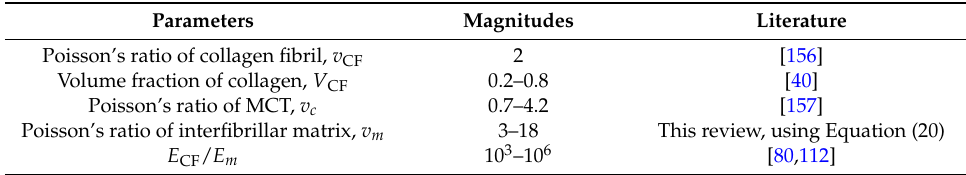
Table 3. Estimates of fibrillar and matrix-related Poisson’s ratio and modulus of elasticity parameters for understanding the behaviour of the interfibrillar